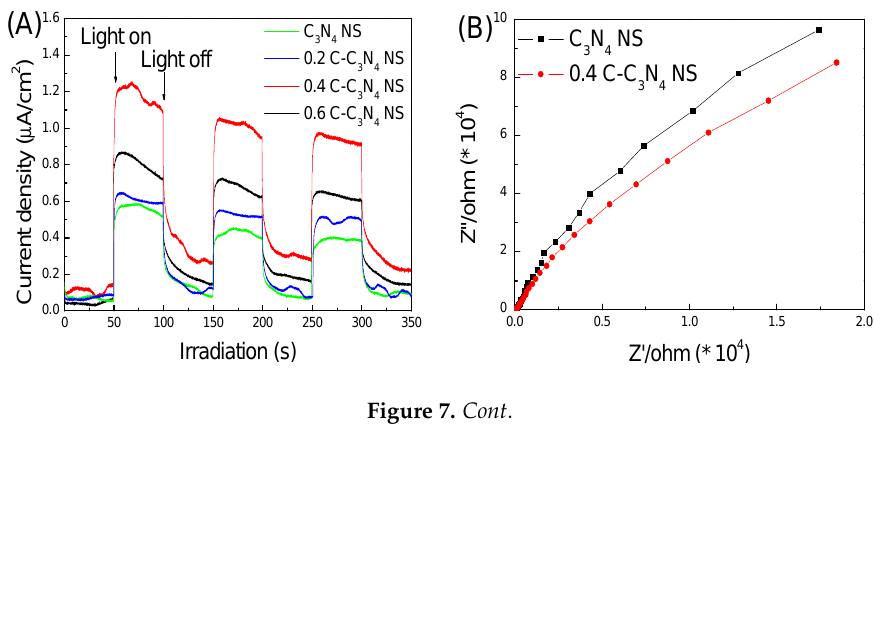
Figure 6. ( A ) Photocatalysis hydrogen evolution and ( B ) volume histogram of series of samples. ( C ) Photocatalysis hydrogen evolution stability test of 0.4 C-C 3 N 4 NS. ( D ) Photocatalysis rhodamine B (RhB) degradation performances of series of samples.